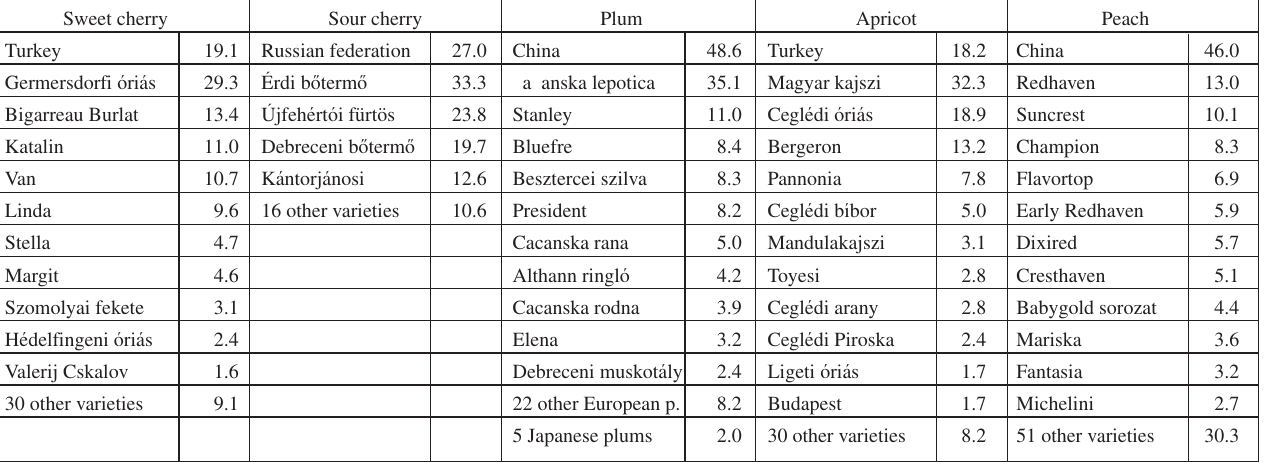
Table 6. Rate of stone fruit varieties multiplied in the nurseries of Hungary